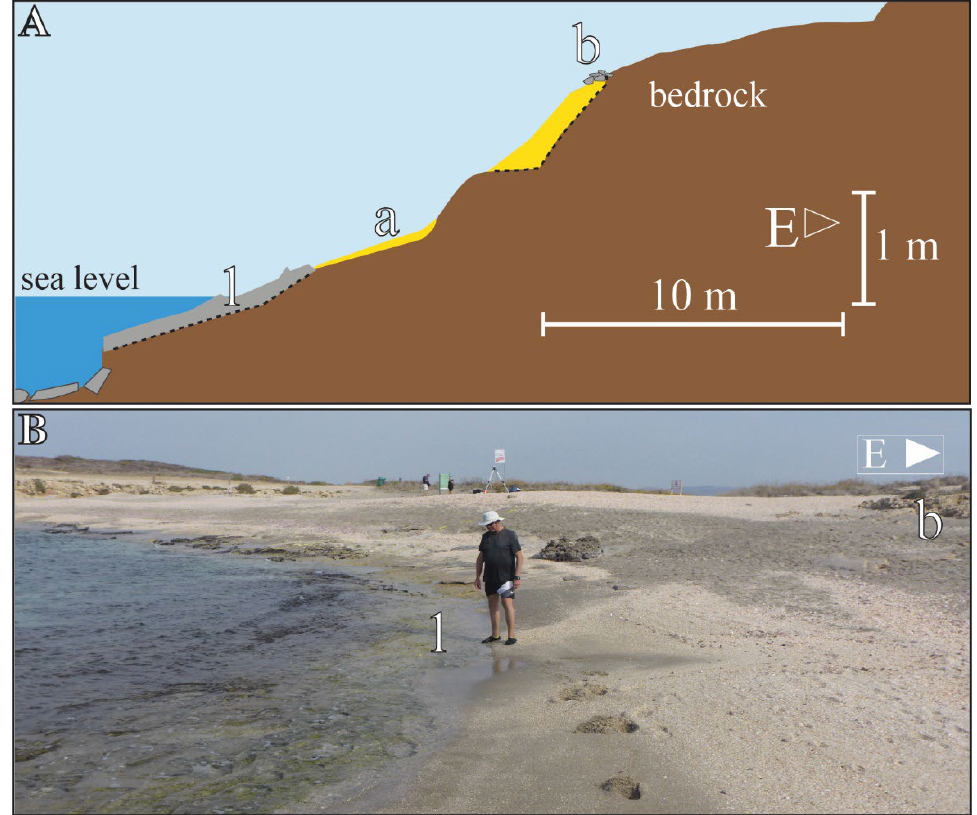
Figure 8. Beachrock exposure in Habonim (Bay 4). ( A ) schematic cross-section of the site (VE = 4, 1 : BR outcrop, ( a ) beach surface sediment consisting of sand and shells, ( b ) beachrock boulders concreated at backshore, dotted line marks uncertain unit contact depth); ( B ) view of the site (notes are as in (A)).